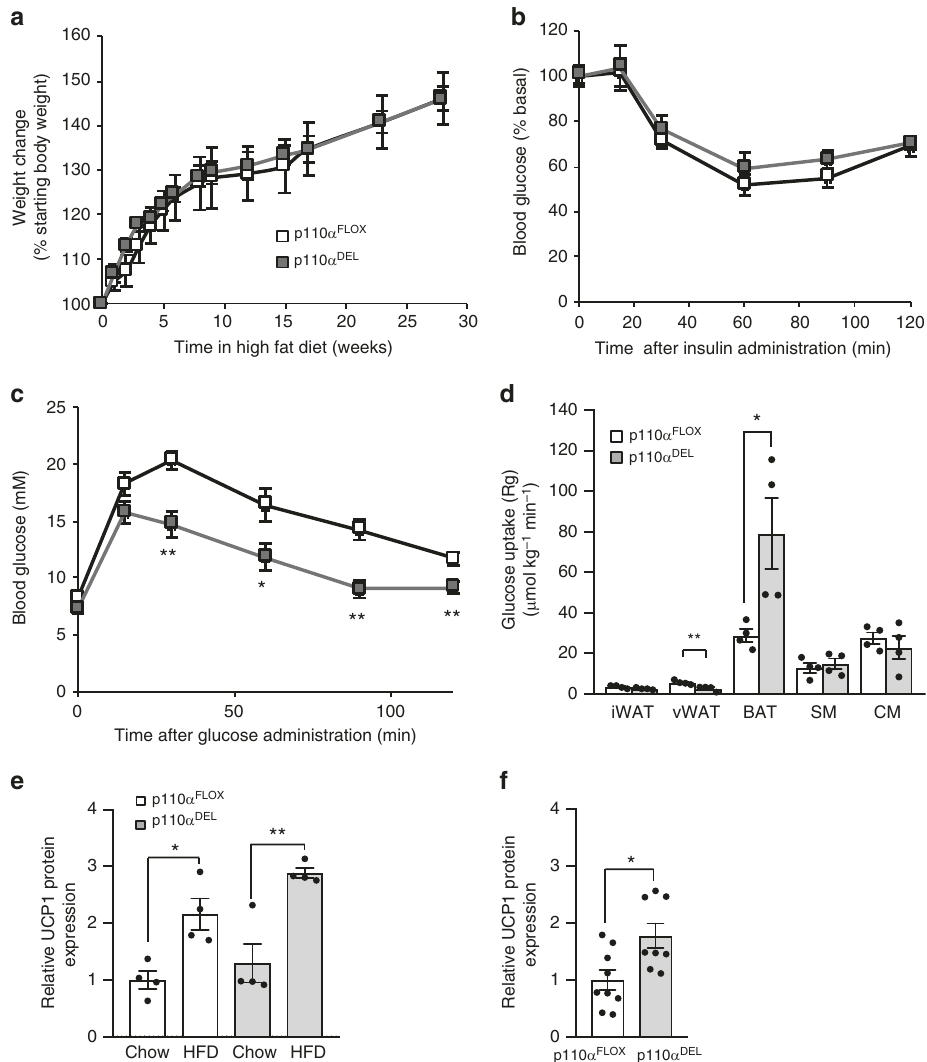
Fig. 3 Increased glucose clearance from BAT of p110 α DEL mice. a Weight gain curves of p110 α FLOX and p110 α DEL littermates. Thirty-week-old male mice ( n = 6 per genotype) were fed a high-fat diet (HFD, 45% of calories from fat) for 28 weeks. b , c ITT ( b ) and GTT ( c ) in HFD-fed mice performed